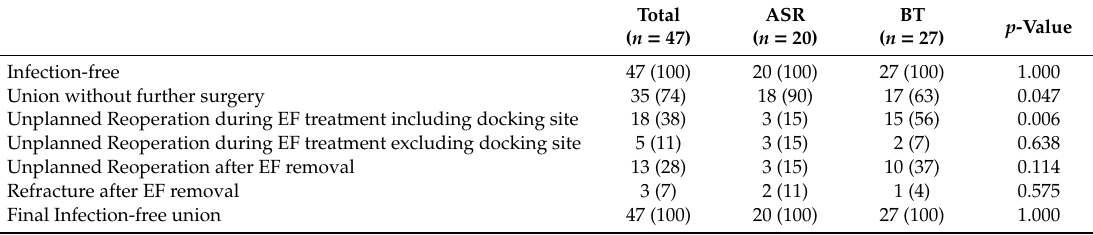
Table 2. Outcome of the treatment of infected tibial segmental defect in the acute shortening / relengthening (ASR) group and the bone transport (BT)